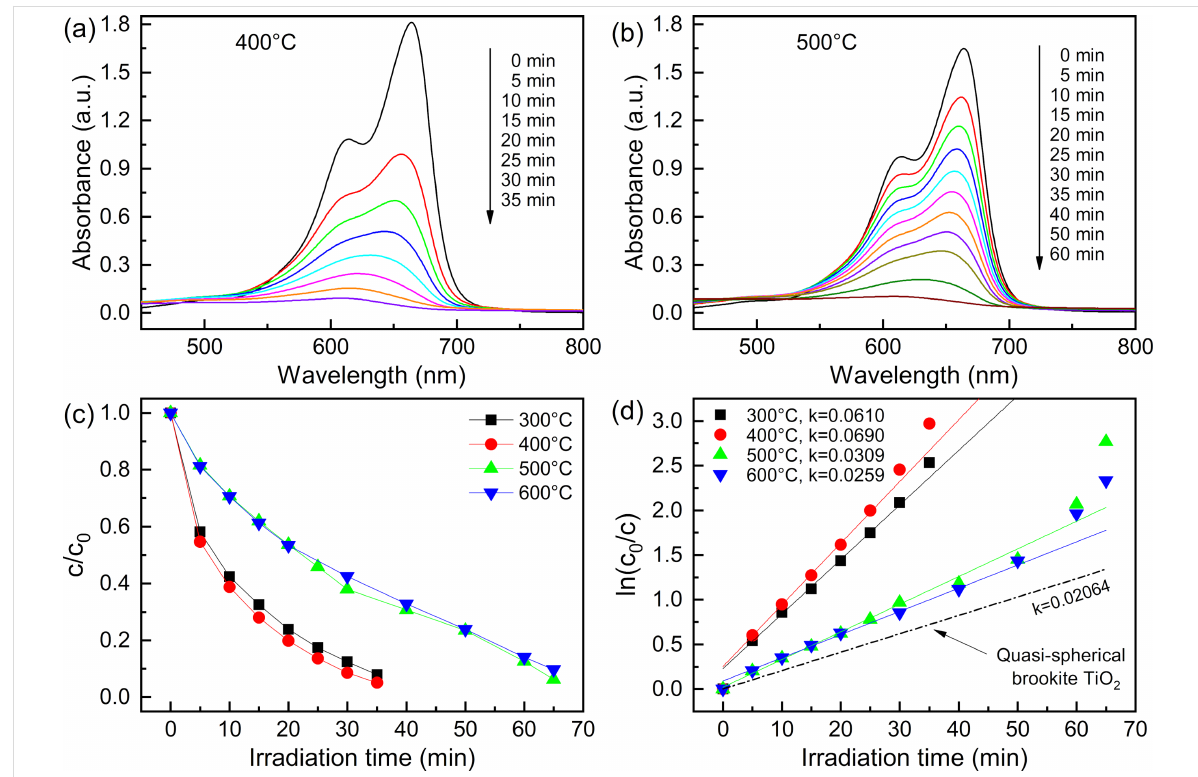
Figure 1: The UV absorption spectra of MB during photocatalytic reactions over samples calcinated at (a) 400 °C, (b) 500 °C. (c) The photodegrada- tion of MB by samples calcinated at 300–600 °C. (d) Variations in ln( c / c 0 ) as a function of the irradiation time, where the dotted line is the quasi- spherical brookite TiO 2 reference ( k =